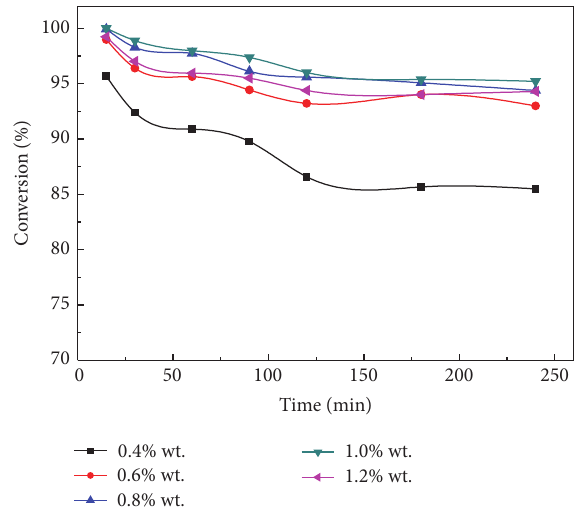
Figure 3: Hydrogen conversion in catalytic dehydrogenation of Pd/SiO 2 and Pd/Al 2 O 3 .